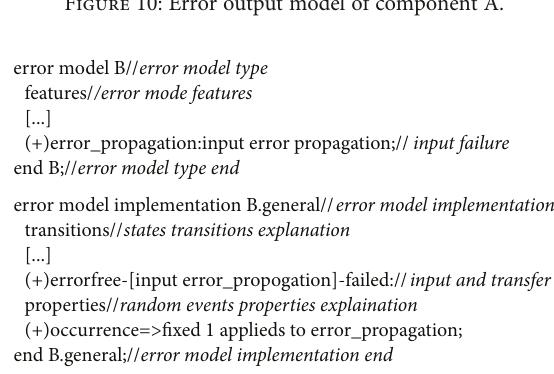
Figure 11: Error input model of component B.